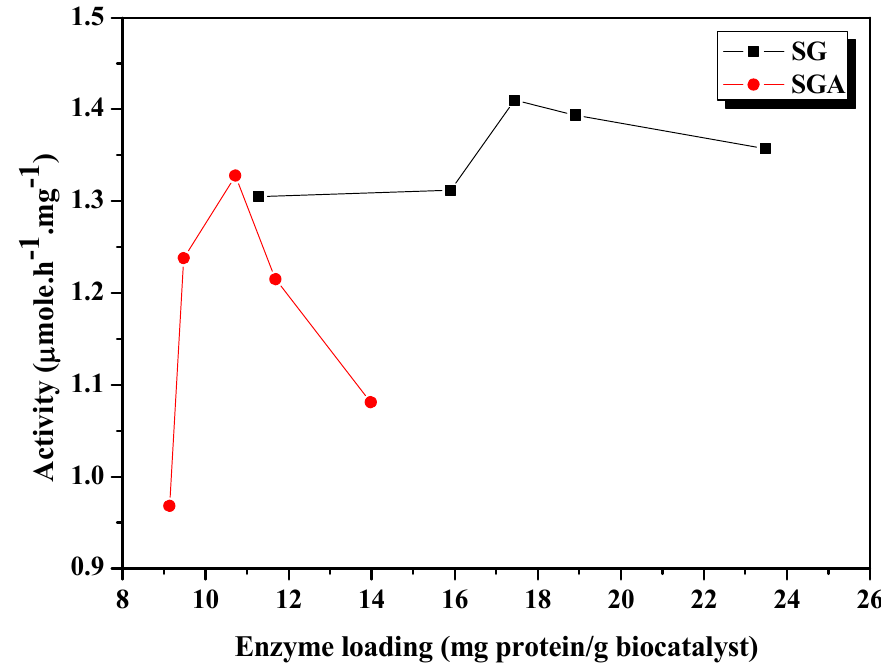
Figure 1. Influence of enzyme loading on catalytic activity of CaLB lipase immobilized by sol-gel entrapment (SG) or sol-gel entrapment combined with adsorption (SGA), in the acylation of 2-octanol at 40 °C, calculated at 6h reaction